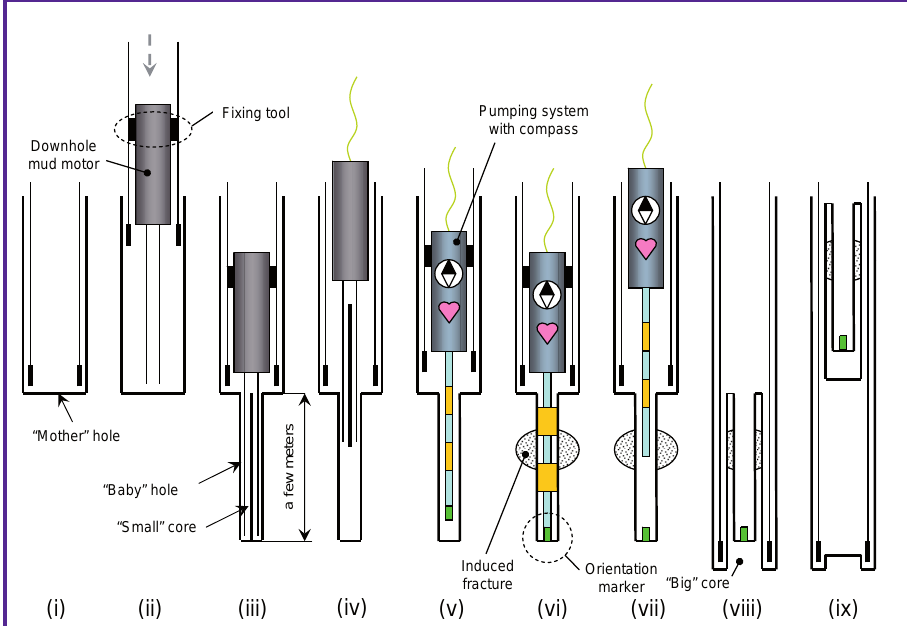
Figure 3. Proposed new strategy, BABHY, to achieve stress measurements by hydraulic fracturing at depths of more than 1 km, and its procedures. The procedure consists of three parts as follows: (i–iv), drilling the baby hole; (v–vii), in situ testing of hydraulic fracturing; and (viii–ix), extending the mother hole and retrieving the large